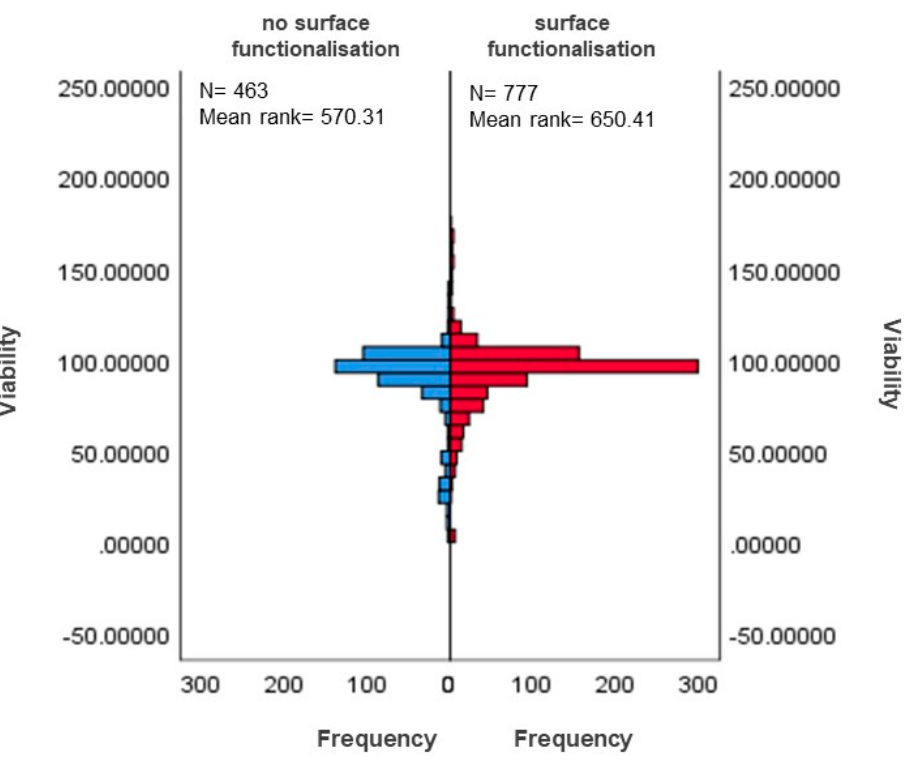
Figure 8. Distributions of functionalised and non-functionalised MSNs viability scores. The graphical representation shows distributions of viability in functionalised and non-functionalised MSNs.